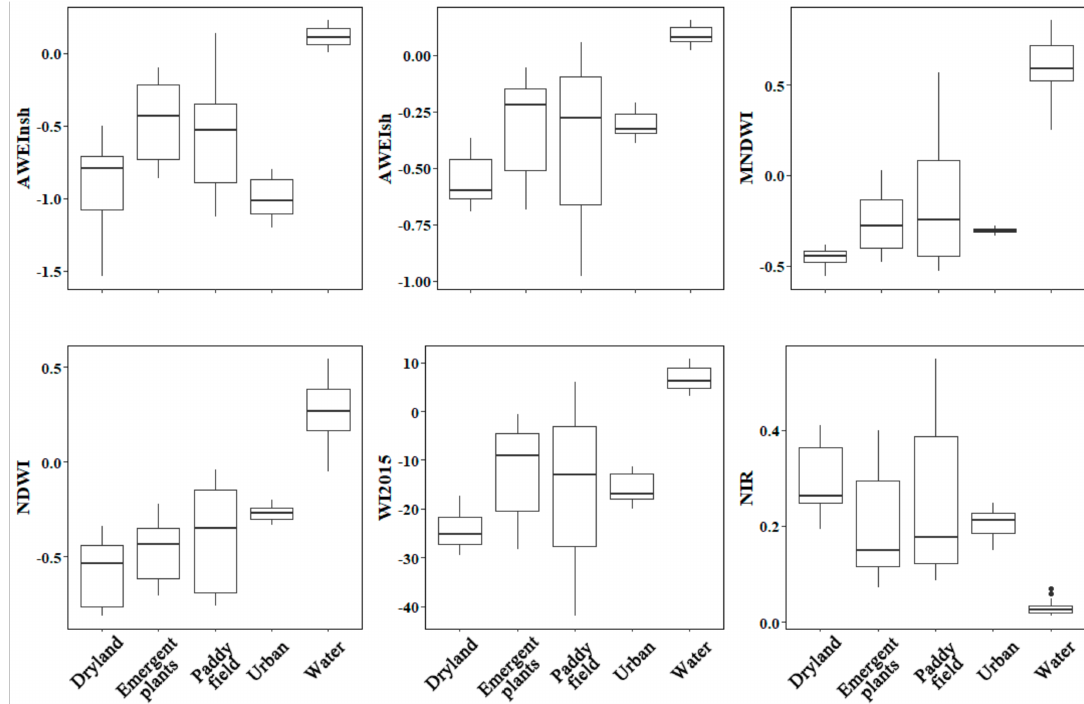
Figure 2. Box plots of the six indices for different landcover types computed from 18 sampling images. Each boxplot shows the location of the 25th, 50th, and 75th percentiles using horizontal lines (boxes and whiskers) and the whiskers extend to the largest and smallest values no further than 1.5 times the interquartile